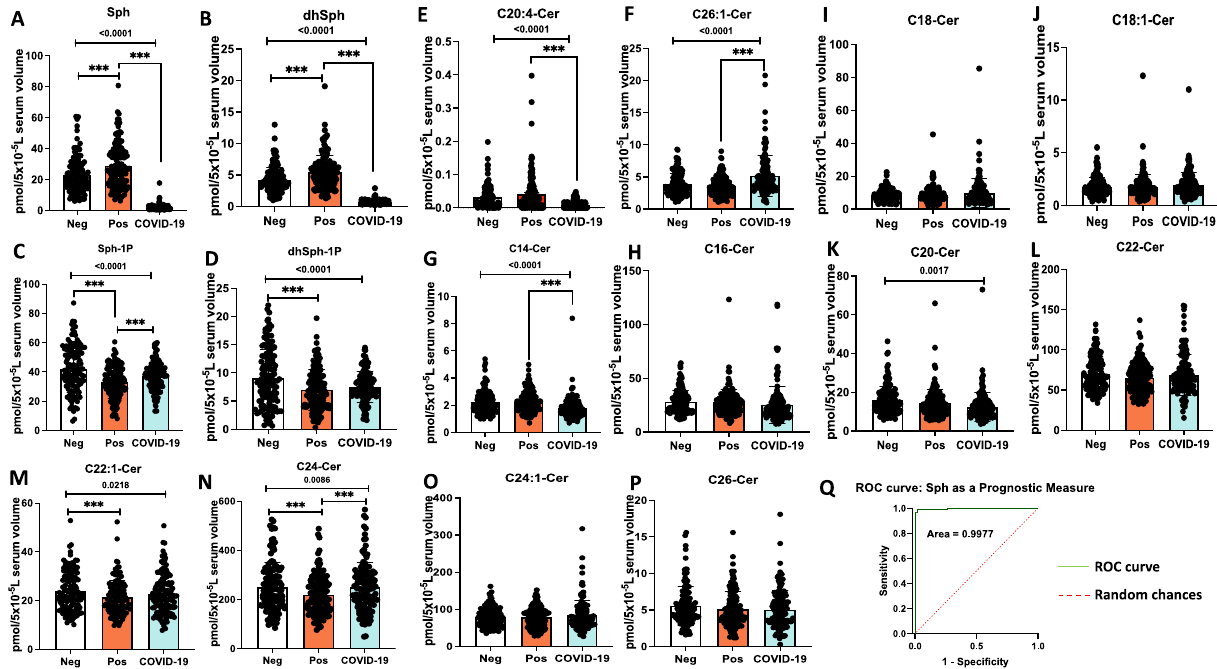
Figure 1. Decreased serum sphingosine level is linked with COVID-19 symptoms. Lipidomics measurements based on High-Performance Liquid Chromatography-tandem Mass Spectrometry (LC–MS/MS) for ( A ) Sphingosine (Sph), ( B ) dihydro-sphingosine (dhSph), ( C ) sphingosine 1-phosphate (Sph-1p), and ( D ) dihydro- sphingosine 1-phosphate (dhSph-1p). LC–MS/MS ceramide (Cer) measurements for ( E ) C20:4-Cer, and ( F ) C26:1 Cer. Moreover, LC–MS/MS ceramide (Cer) measurements for ( G ) C14-Cer, ( H ) C16-Cer, ( I ) C18-Cer, ( J ) C18:1-Cer, ( K ) C20-Cer, ( L ) C22-Cer, ( M ) C22:1-Cer, ( N ) C24-Cer, ( O ) C24:1-Cer, and ( P ) C26-Cer. ( Q ) Graphical ROC (receiving-operating characteristics) curve for Sph as a prognostic measure, produced by plotting Sensitivity(true positive rate) against 1-Specificity (false positive rate). Area under the ROC curve is 0.9977 or 99.77%. The light green line (ROC curve) shows combinations of sensitivity and specificity for threshold values, while the red dotted line (Random chances) indicates a reference cut-off point for a useful model. Neg negative antibody test (n = 130), Pos asymptomatic positive antibody test (n = 134), COVID-19 symptomatic patients (n = 131). Data are means of ± SEM, and P < 0.05 is considered significant. Comparisons significant at the 0.05 level are indicated by